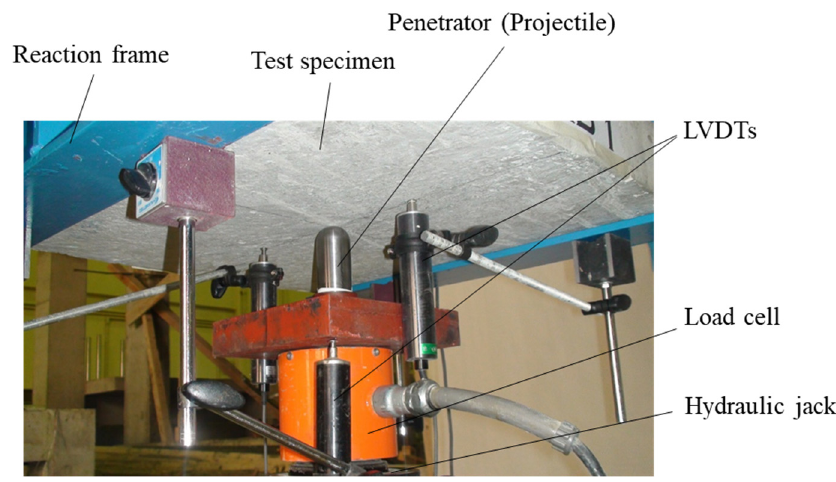
Figure 3. Test setup for quasi-static punching test of RC slabs using projectile as a penetrator.